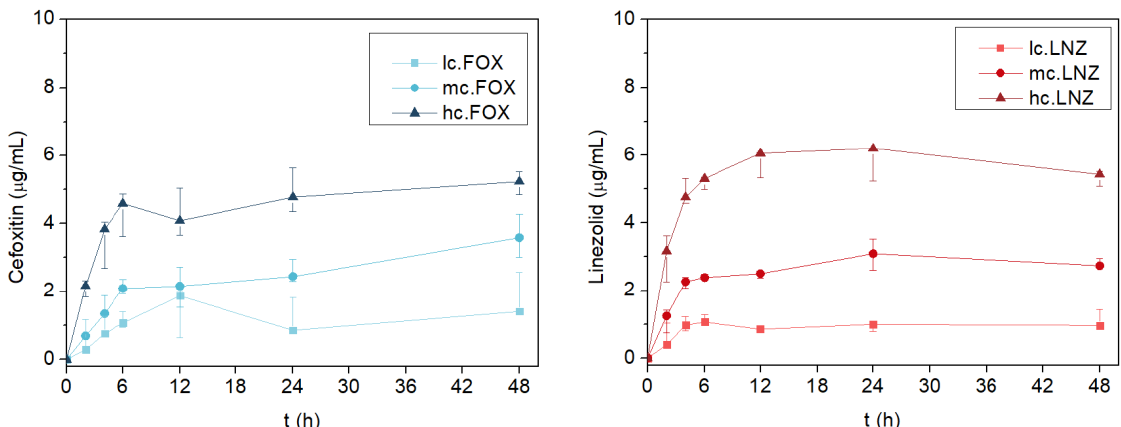
Figure 6. Kinetics of ( left ) cefoxitin and ( right ) linezolid released over time determined by UV-VIS absorbance. Data are represented as the median and interquartile range of the amount of antibiotic measured in three replicates.